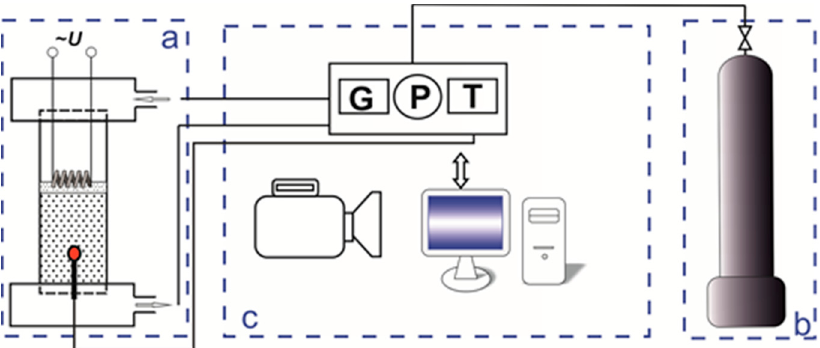
Figure 1. Scheme of an experimental equipment for studying combustion metals under forced filtration. (a) a reactor; (b) a gas supply unit; (c) a unit for registering and processing data.